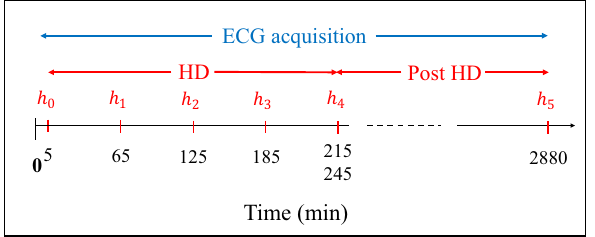
Figure 1. Diagram of the study protocol: h 0 to h 5 are the time points (in minutes) for blood sample extraction. h 4 is taken at the end of the HD (minute 215-th or 245-th, depending on the HD